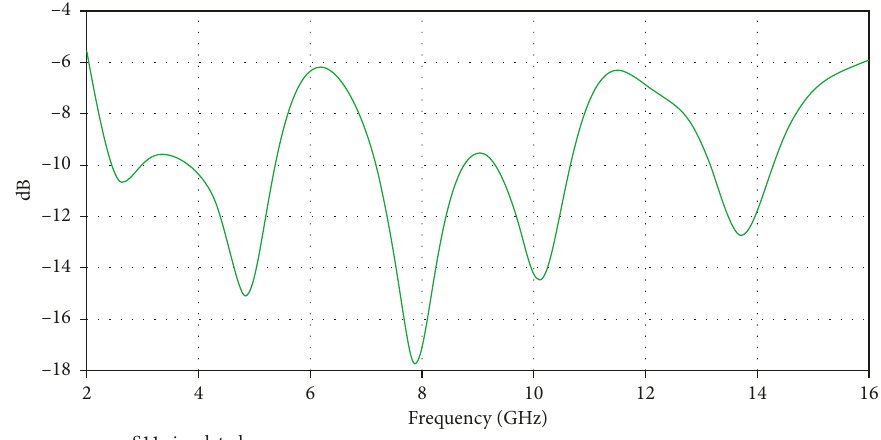
Figure 3: S 11 simulated plot for pentaband cross stub circular monopole antenna.